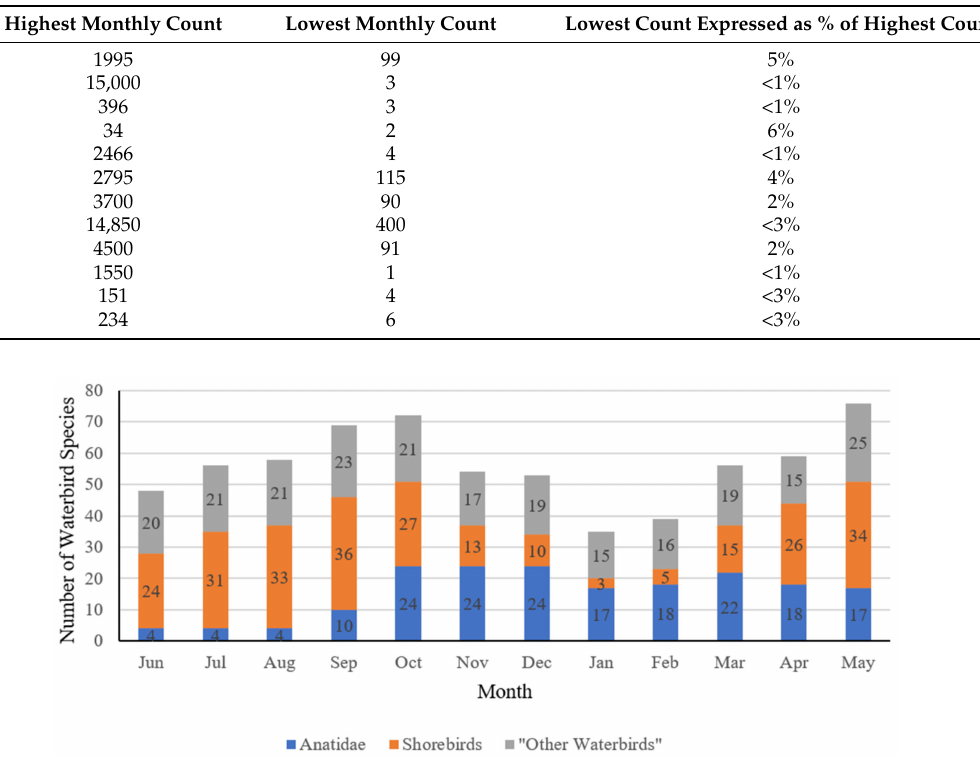
Table 2. The highest and lowest monthly counts of those waterbird species which were recorded